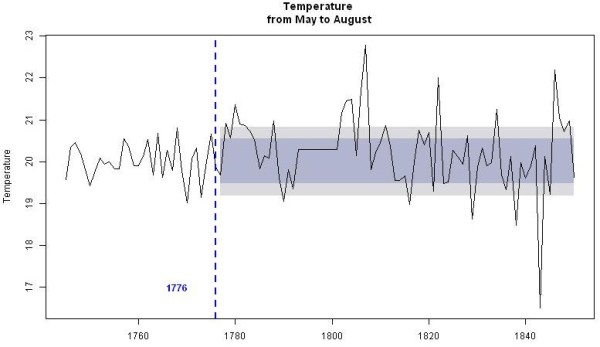
Study of the fluctuations of the mean temperature from May to August using a Gaussian white noise model. The year 1776 was the epidemic breakpoint. An Arima model was used to plot prediction intervals at confidence levels of 80% and 95% in light grey and grey, respectively.